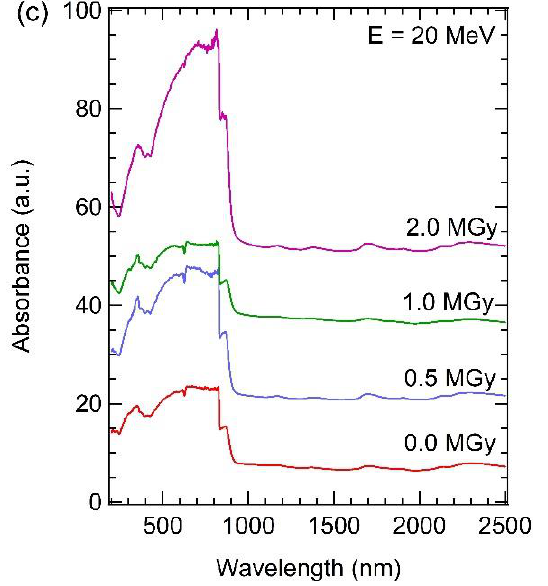
Figure 9. UV-VIS spectra of GaAs samples irradiated with different energy of ( a ) 10; ( b ) 15; and ( c ) 20 MeV.